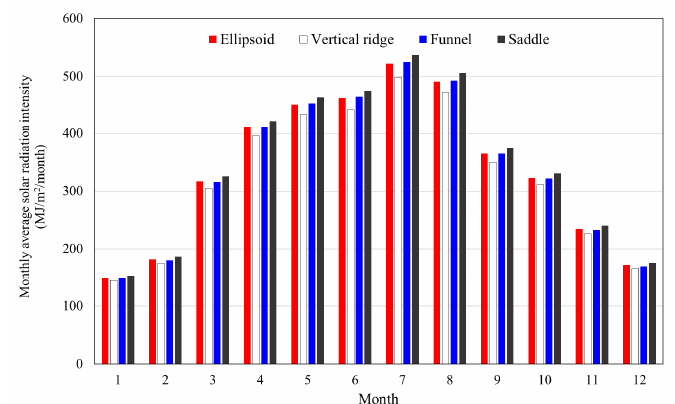
Figure 16. Monthly average solar radiation intensity of elliptic gymnasium buildings with the four roof shapes.